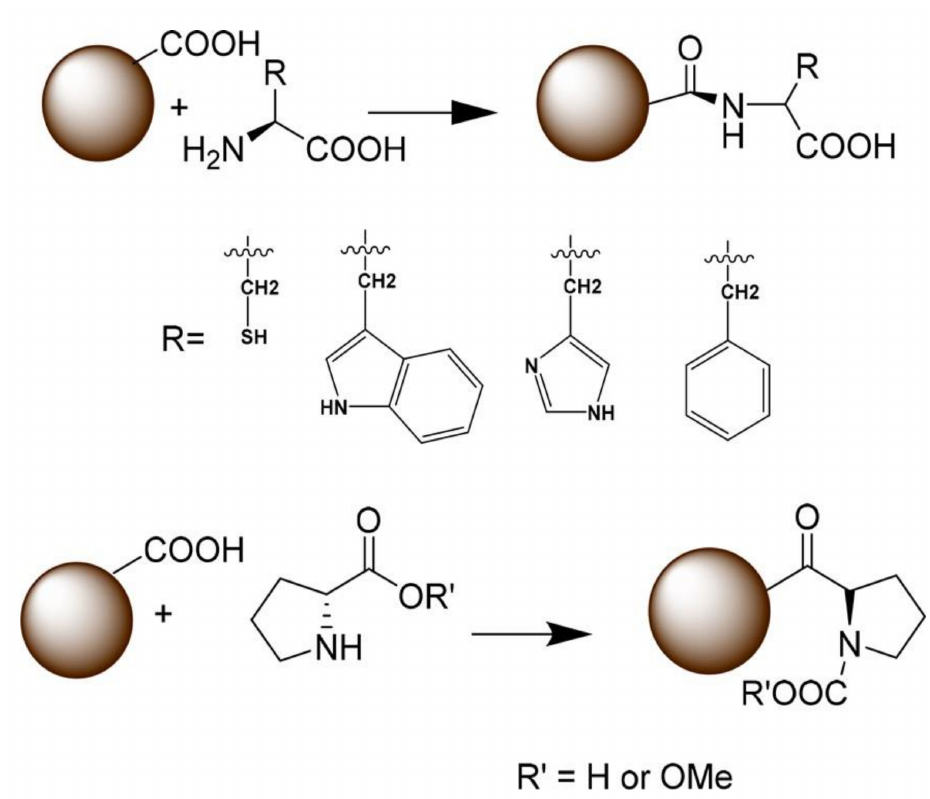
Figure 5. Schematic representation of the conjugation of amino acids on the CQDs surface. Reprinted with permission from ref. [82]. Copyright 2018 American Chemical